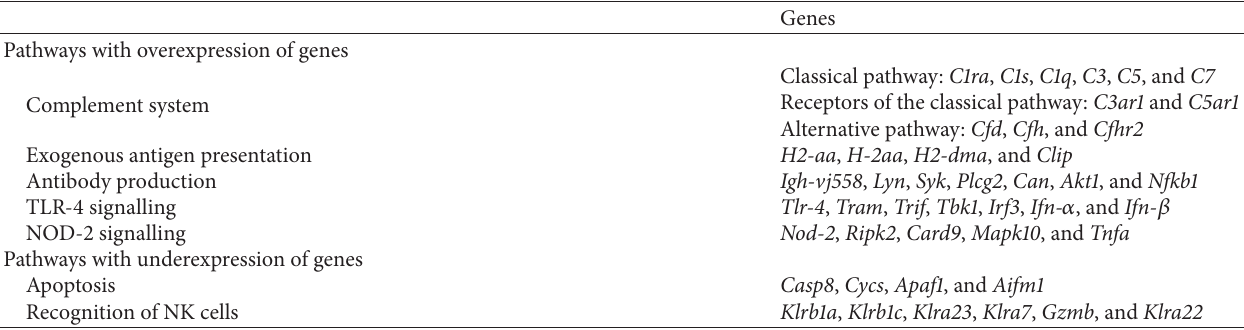
Table 1: Gene expression in mice with a disease resembling human lupus triggered by liposomes with Mn 2+ -induced or chlorpromazine- induced nonbilayer phospholipid arrangements.